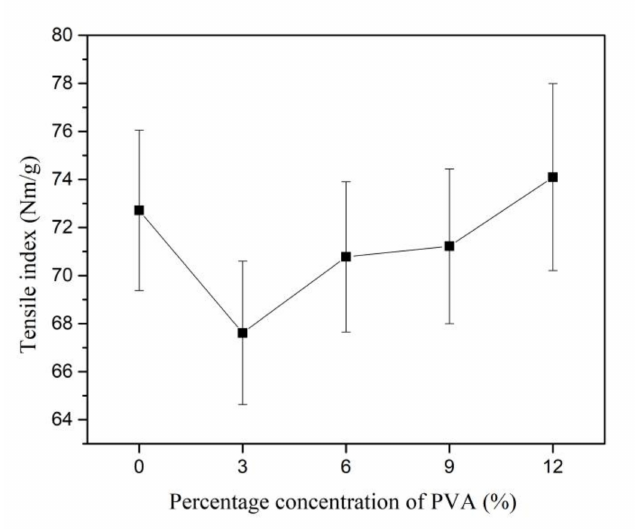
Figure 18. Tensile index of Kenaf paper at di ff erent weight percentage concentration of PVA.